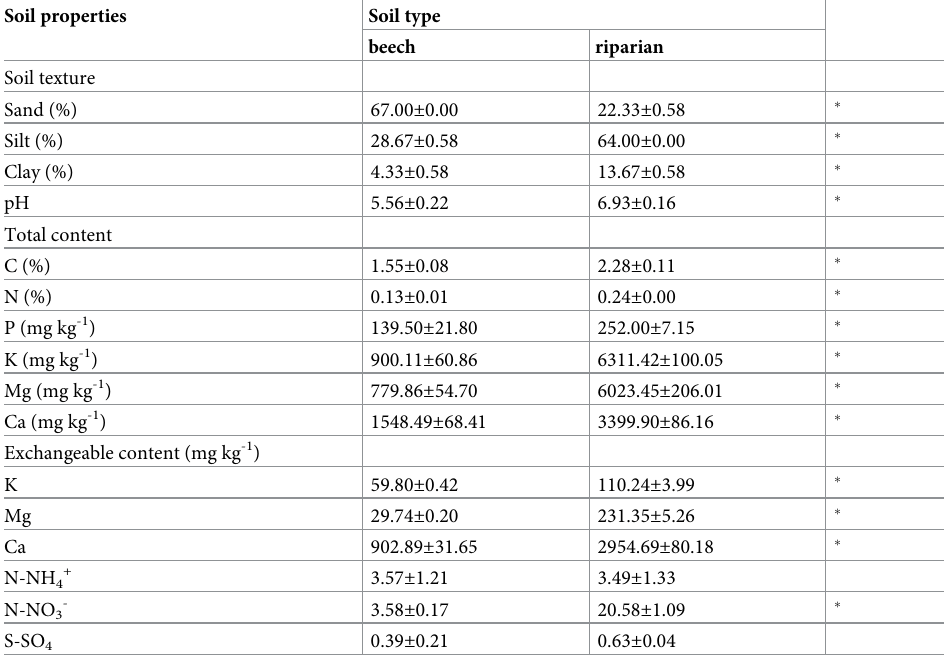
Table 1. Physical and chemical properties (mean ± SD; N = 3) of beech and riparian soils used in the experiment. Soil properties